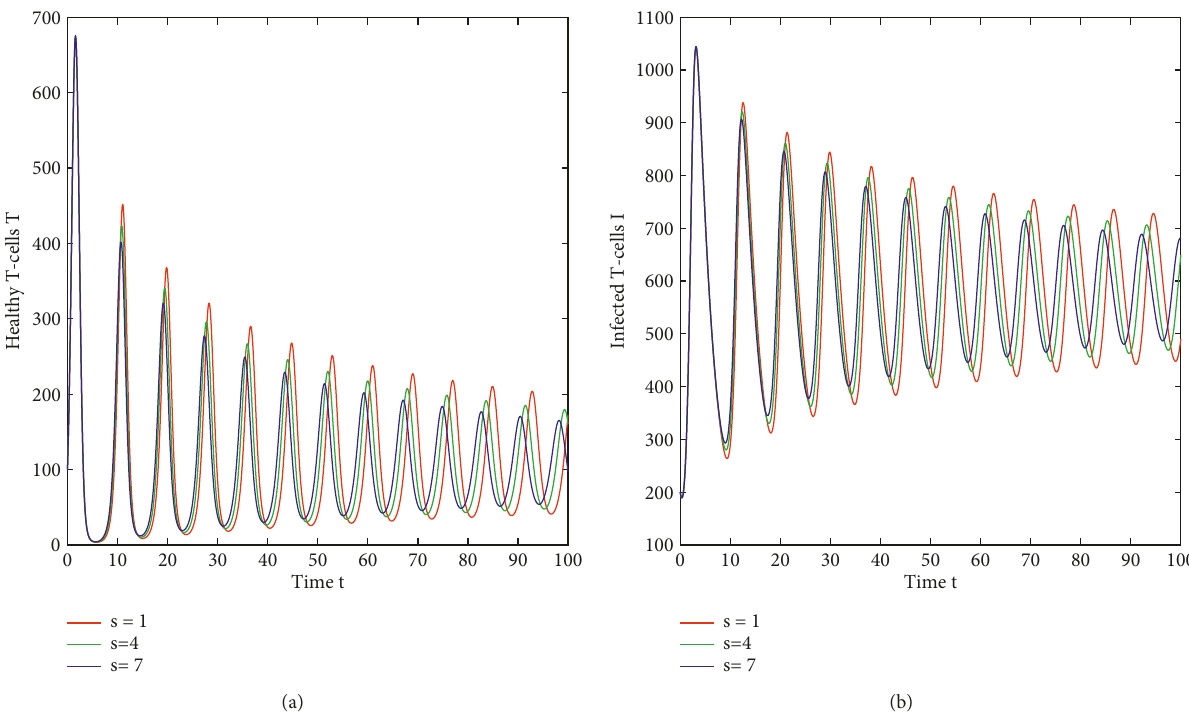
Figure 10: Graphical view analysis of the time series of the suggested fractional model (2) of HIV with the variation of s , i.e., s � 1.0, 4.0,